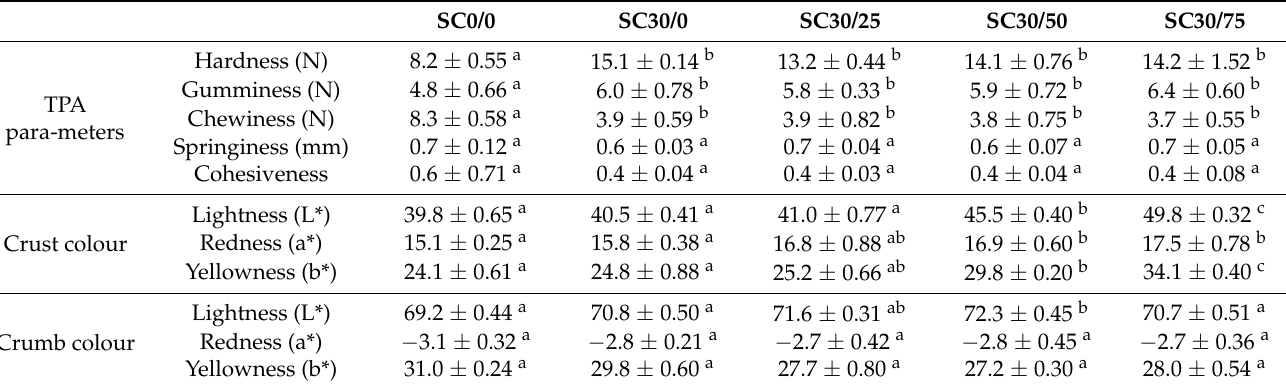
Table 5. Physical properties of sponge cake samples.